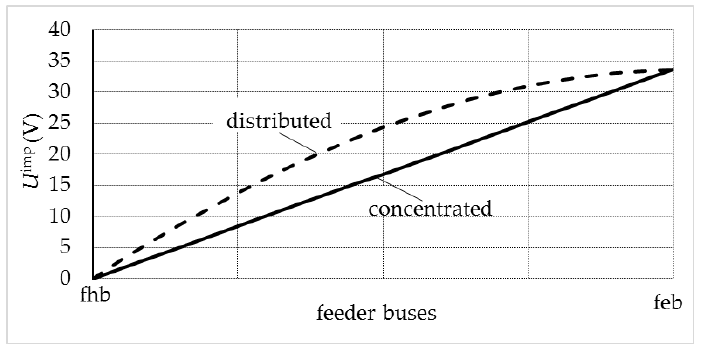
Figure 9. The impact of the distributed and concentrated var-sink cases on voltage profile.